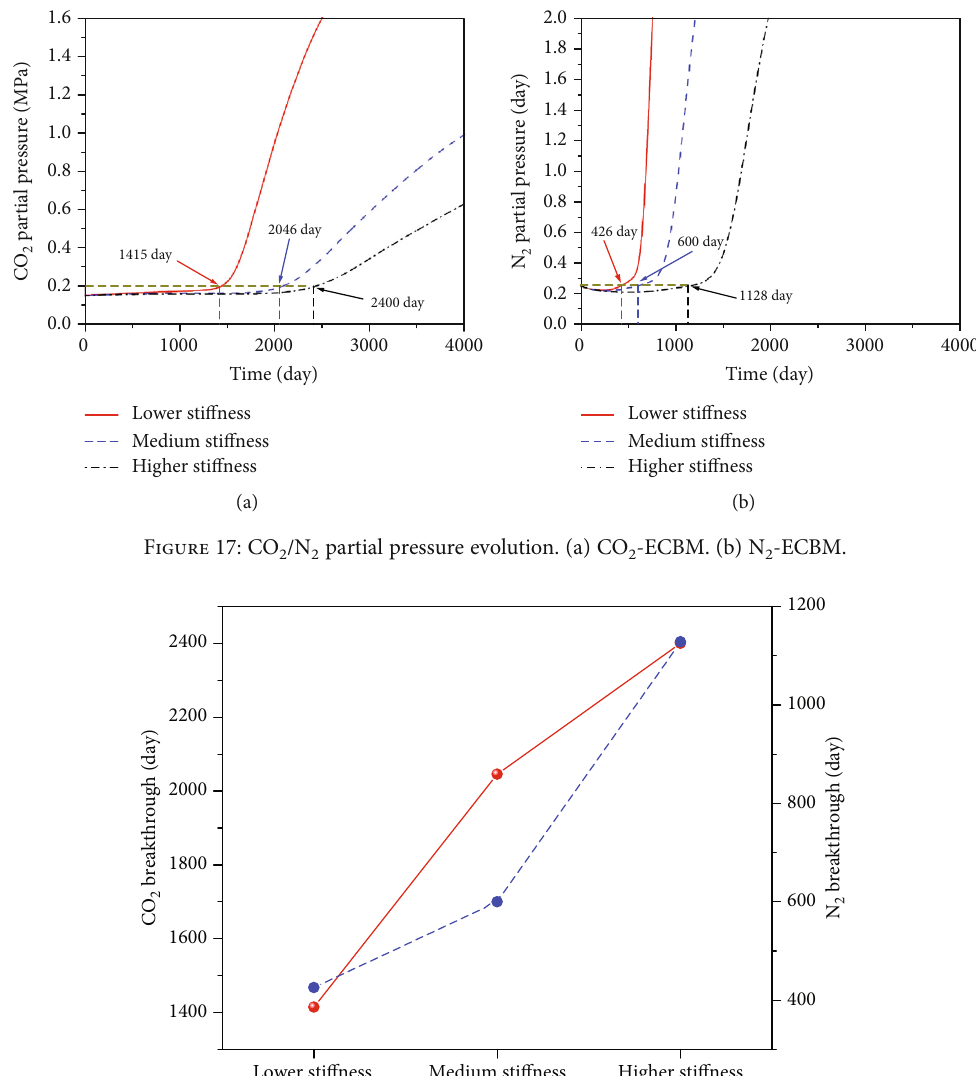
Figure 18: CO and N breakthrough of di ff erent sti ff ness of coal seams. 2 2